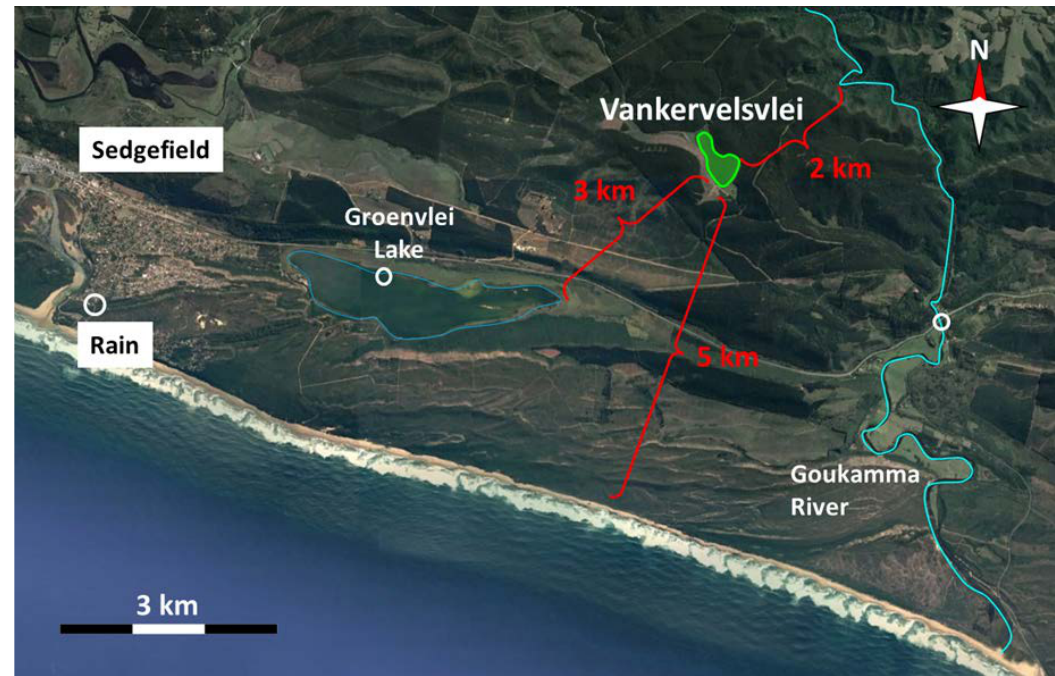
Figure 1. Location of the Vankervelsvlei study area. White circles show the locations of surface water (Goukamma River, Groenvlei Lake) and rainwater (Sedgefield)